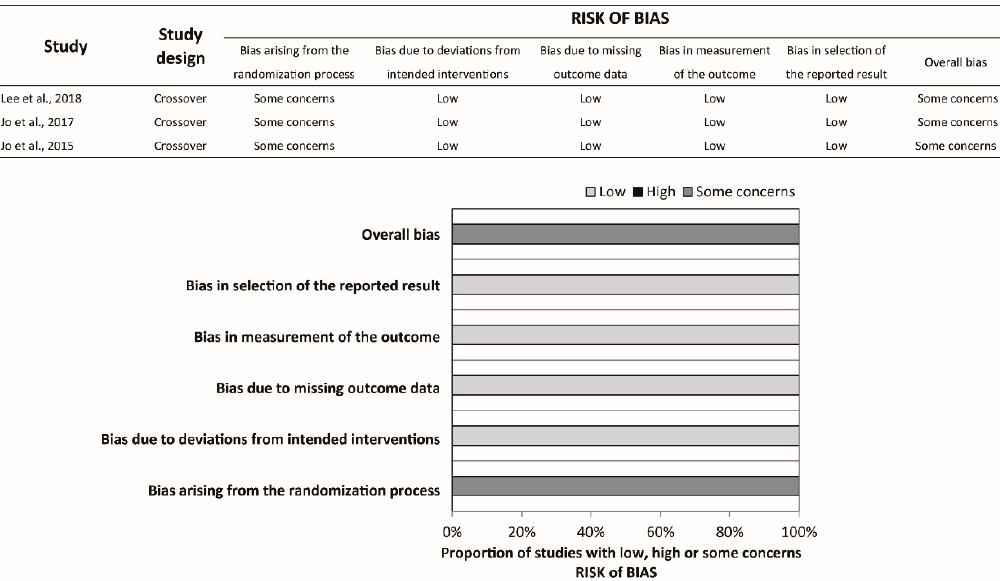
Figure 4. Risk of bias summary and graph of hands-off time.